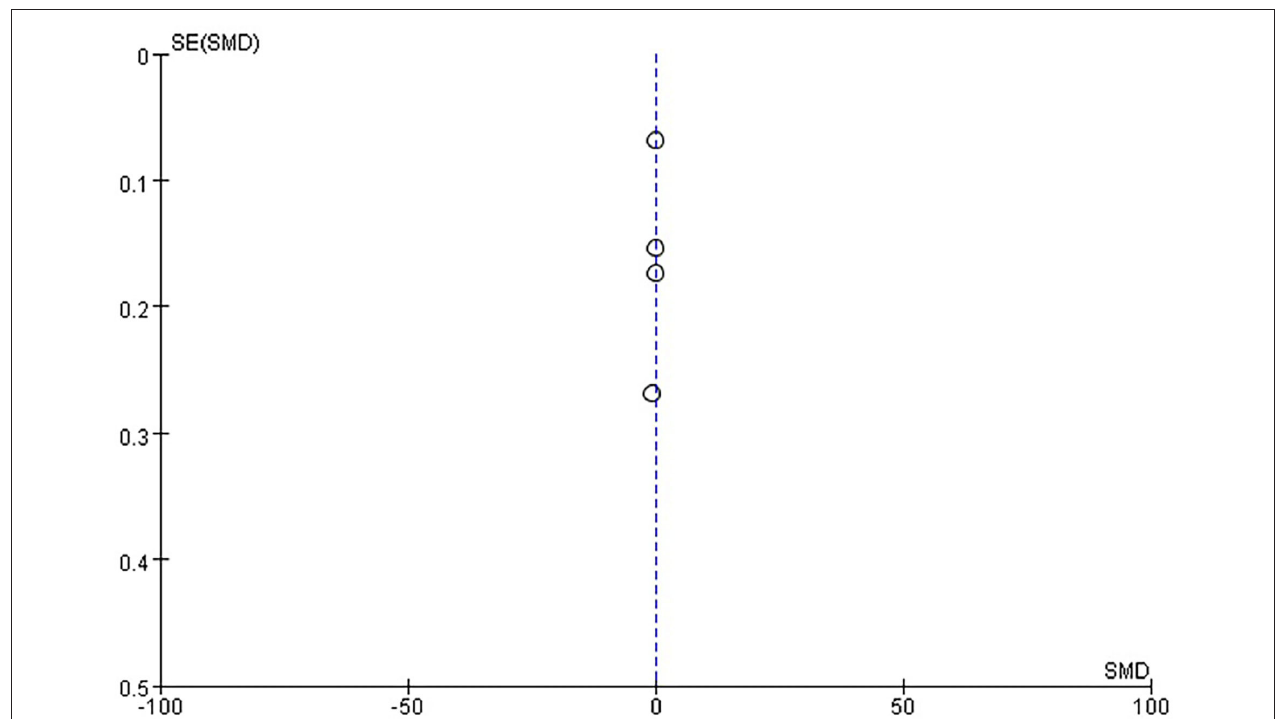
FIGURE 10 | Funnel plot of comparison: ESD care vs. usual care, outcome: modified Rankin scale (mRS).